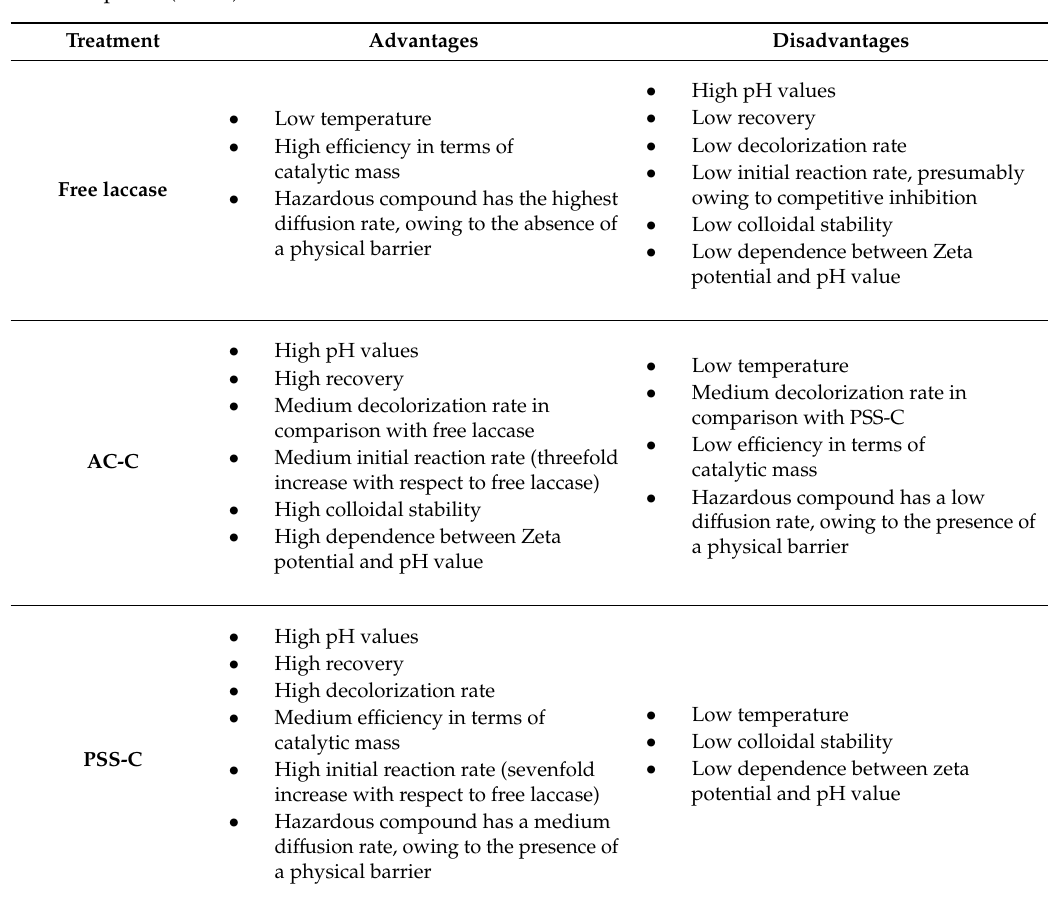
Table 2. Comparisonbetweenfreelaccase,alginate / chitosanmicrocapsules(AC-C),andpoly(styrenesulfonate) microcapsules